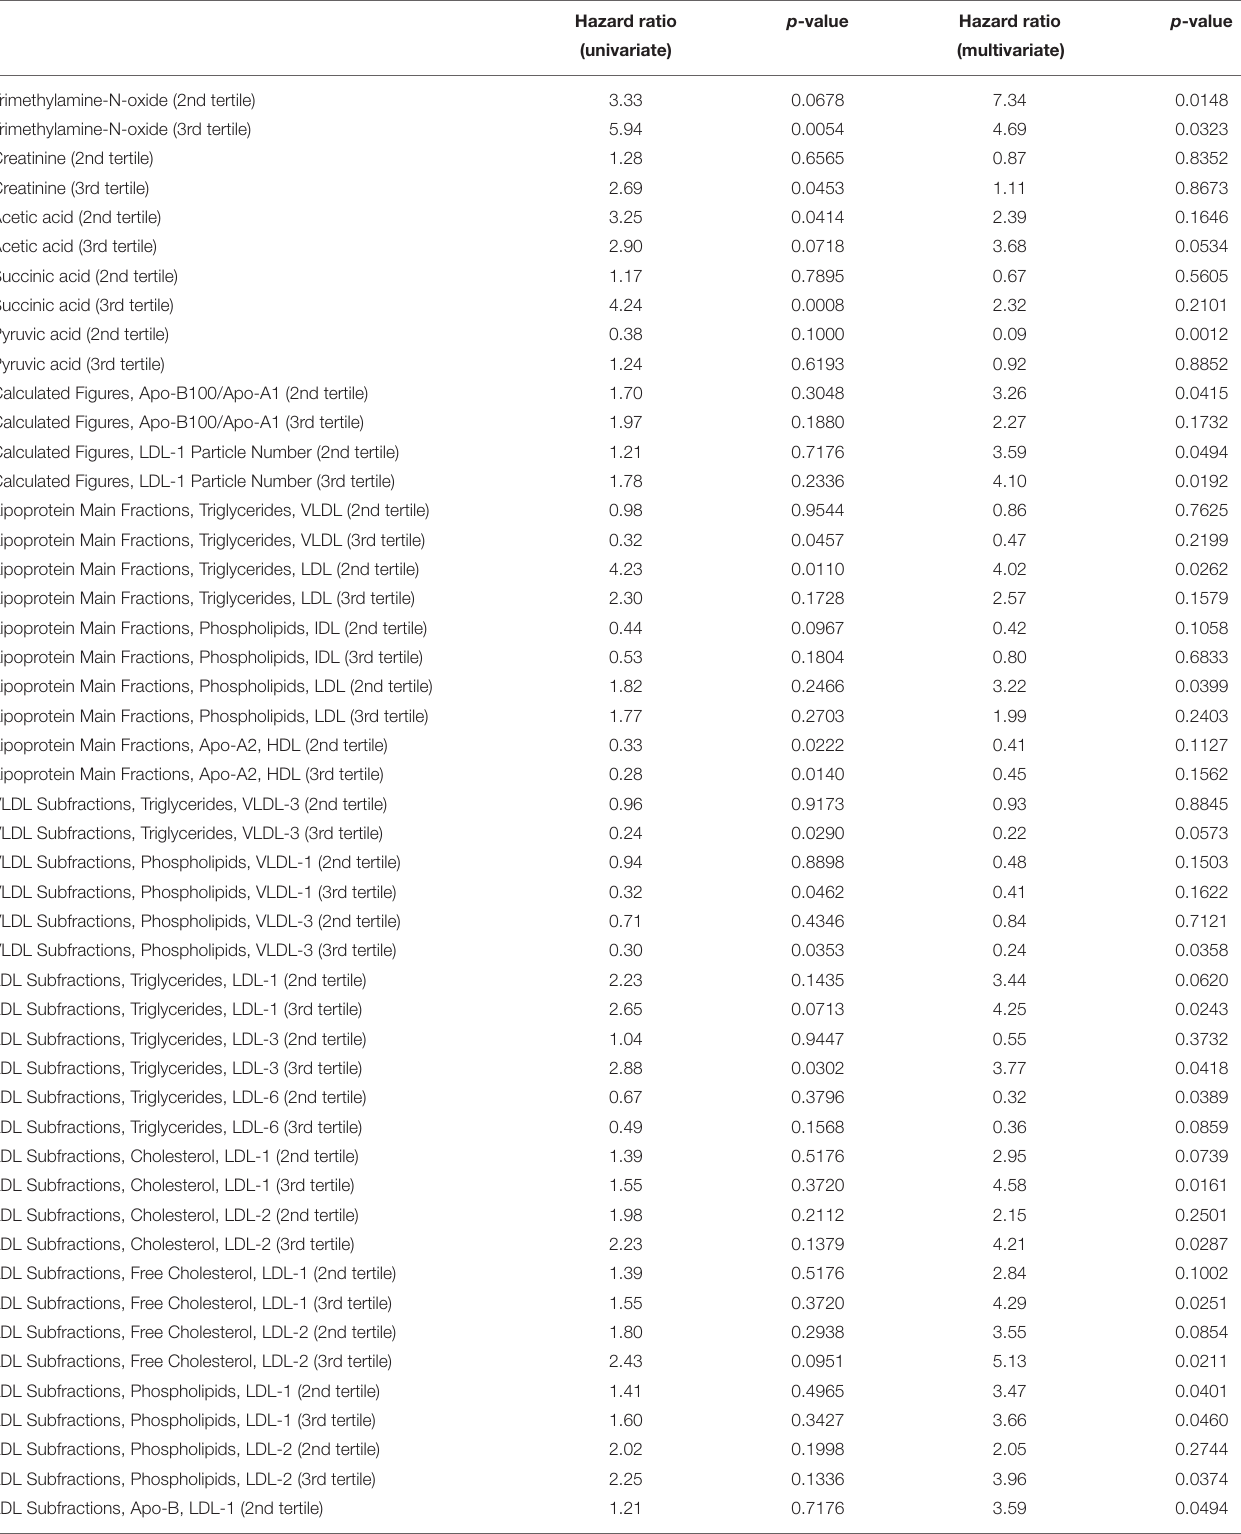
TABLE 3 | Association between metabolites/lipoproteins and the outcome: results of univariate and multivariate (adjusted for sex, age at DCM diagnosis, time from DCM diagnosis and last follow up, NT-proBNP, LVEF, NYHA class at enrollment, SBP, EDDi at enrollment, LAVi at enrollment) Cox regression analyses are reported. Hazard ratio p